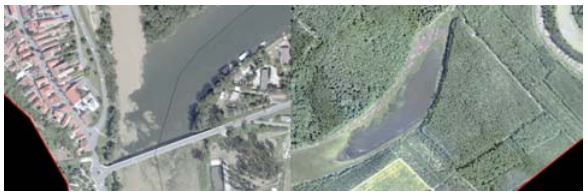
Figure 5. Orthophoto 2.2.3 Digital Terrain Model (DTM)